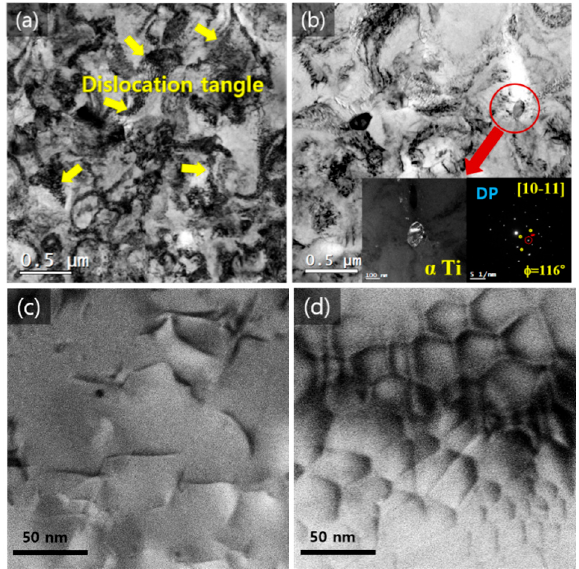
Figure 4. Bright-field transmission electron microscope (TEM) micrographs of ( a , c ) STEP-0 and ( b , d ) STEP-5. Insets in ( b ): dark-field image of α particle and corresponding selected-area di ff raction pattern. Figure 4c,d are high-magnification images.